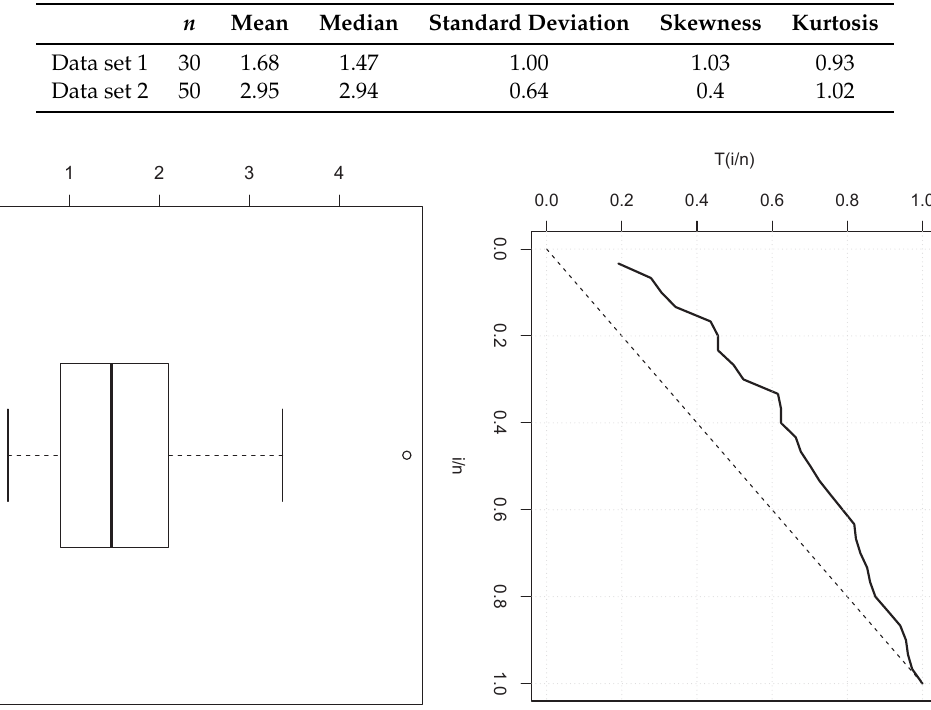
Figure 9. Total test time (TTT) plot and boxplot for data set